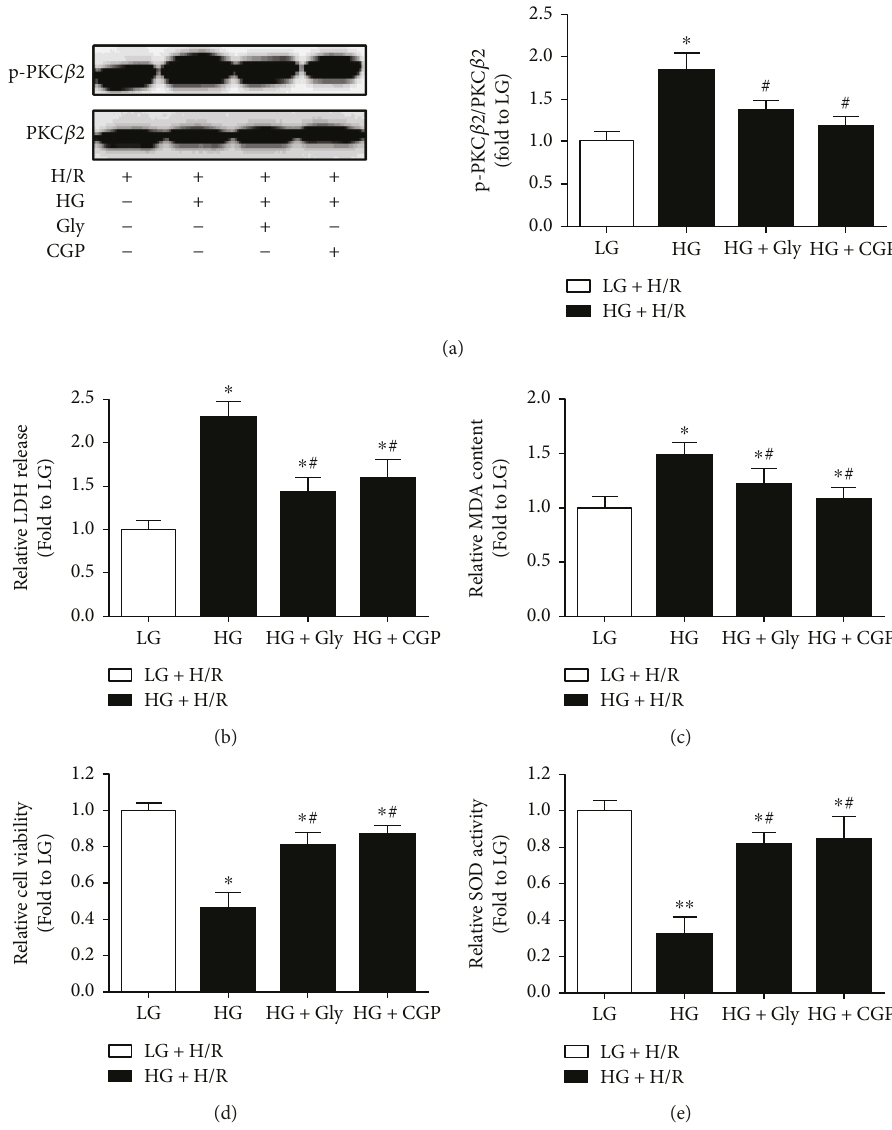
Figure 3: E ff ects of glycine (Gly) and CGP53353 (CGP) on PKC β 2 activation (a), LDH release (b), MDA production (c), cellular viability (d), and SOD activity (e) in H9C2 cells subjected to high glucose (HG) and hypoxia/reoxygenation (H/R) insult. All the results are expressed as mean ± SD ( n = 8 ). Di ff erences were determined by using one-way ANOVA followed by Tukey ’ s post hoc test. ∗ P < 0 05 , ∗∗ P < 0 01 versus LG (low glucose)+ H/R groups, and # P < 0 05 versus HG